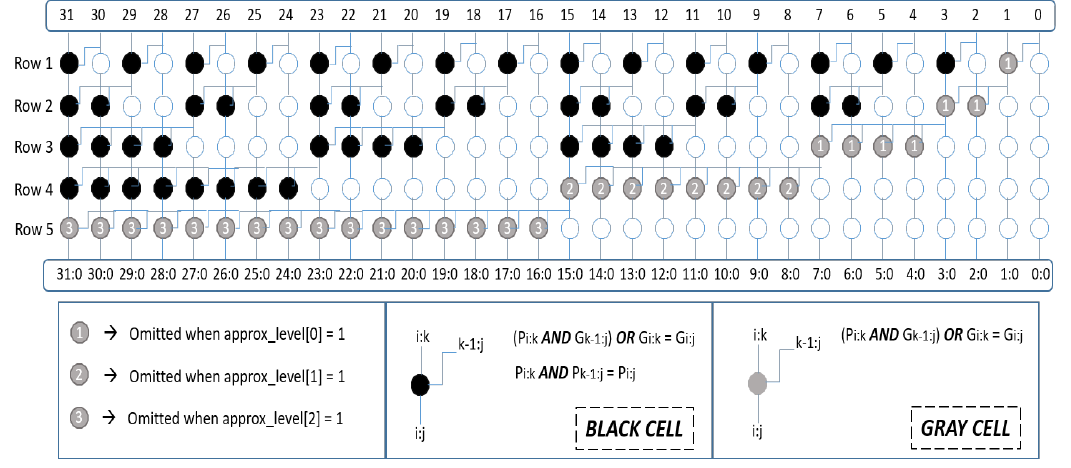
Figure 7. Sklansky adder tree used for approximate adder design.